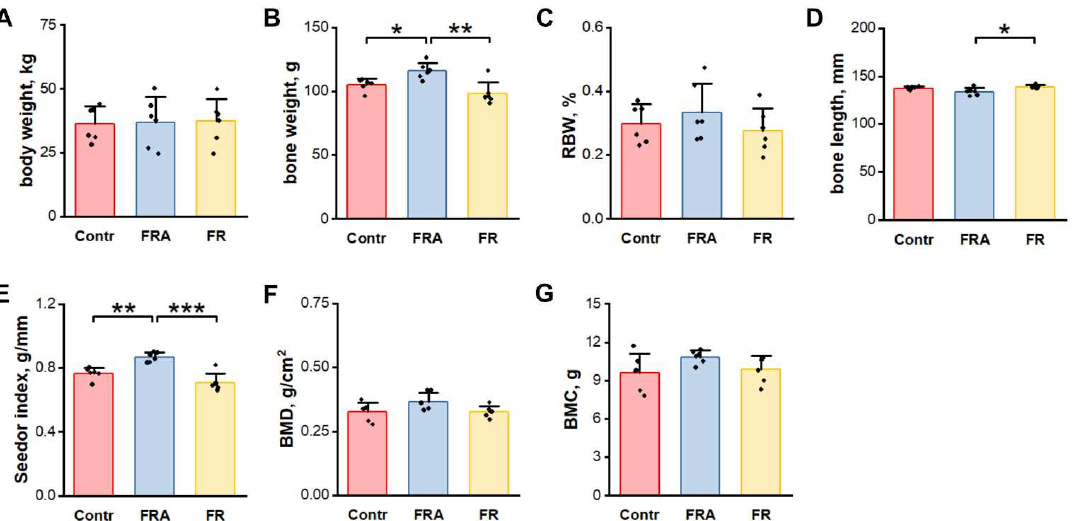
Figure 1. ( A ) Pig weights and basic femur properties of animals in experimental groups: ( B ) bone weight, ( C ) relative bone weight (RBW), ( D ) bone length, ( E ) the Seedor index, ( F ) bone mineral density (BMD), ( G ) bone mineral content (BMC). Bar plots show mean values and standard errors. A range of p -values has been assigned above plots where two groups show significant differences: * p < 0.05, ** p < 0.01, *** p < 0.001.